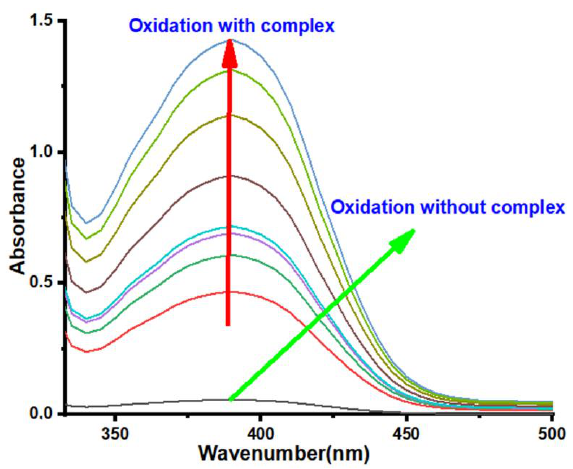
Figure 3. Absorbance spectrum of o -quinone as a function of time for the 2 L 2 /CuSO 4 combination. Figure 1. Absorbance spectrum of o -quinone as a function of time for the 2 L